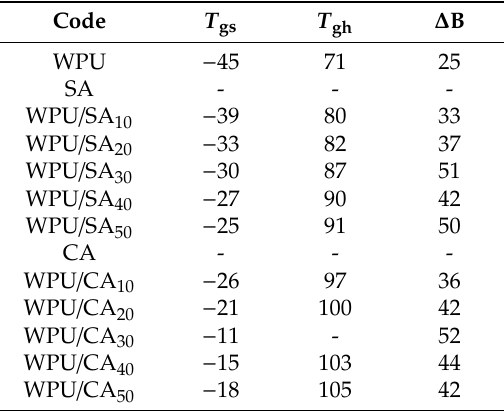
Figure 4. Di ff erential scanning calorimeter (DSC) thermograms of the WPU, SA, and WPU / SA blends Figure 4. Differential scanning calorimeter (DSC) thermograms of the WPU, SA, and WPU/SA blends ( a ) and the WPU, CA, and WPU/CA blends ( b ). ( a ) and the WPU, CA, and WPU / CA blends ( b ). Table 2. Phase transition temperature ( ◦ Table 2. Phase transition temperature (°C).